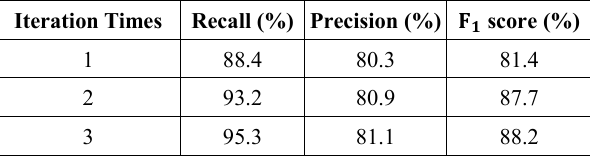
Table 1. Results of performance